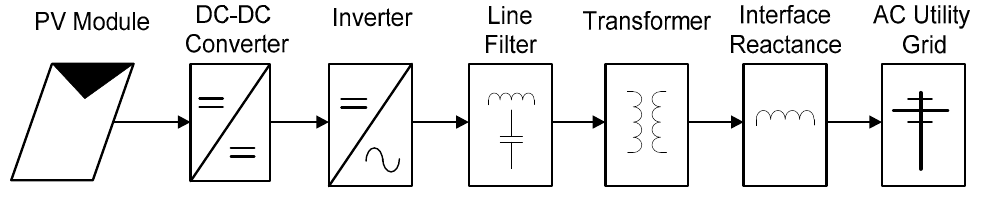
Figure 2. Single line diagram of the GPV generation system.